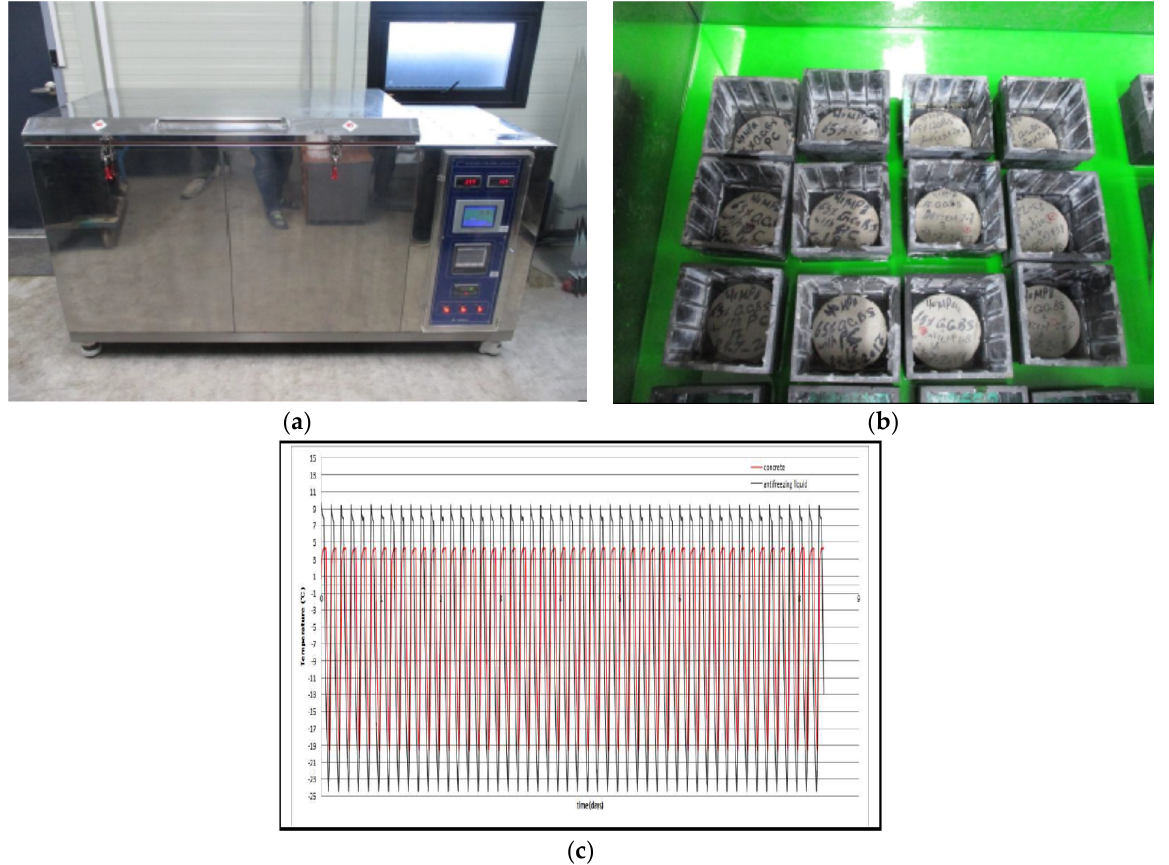
Figure 4. Test B method under cryogenic condition: ( a ) freezing-thawing equipment, ( b ) test set-up with specimens and ( c ) freeze-thaw cycles.